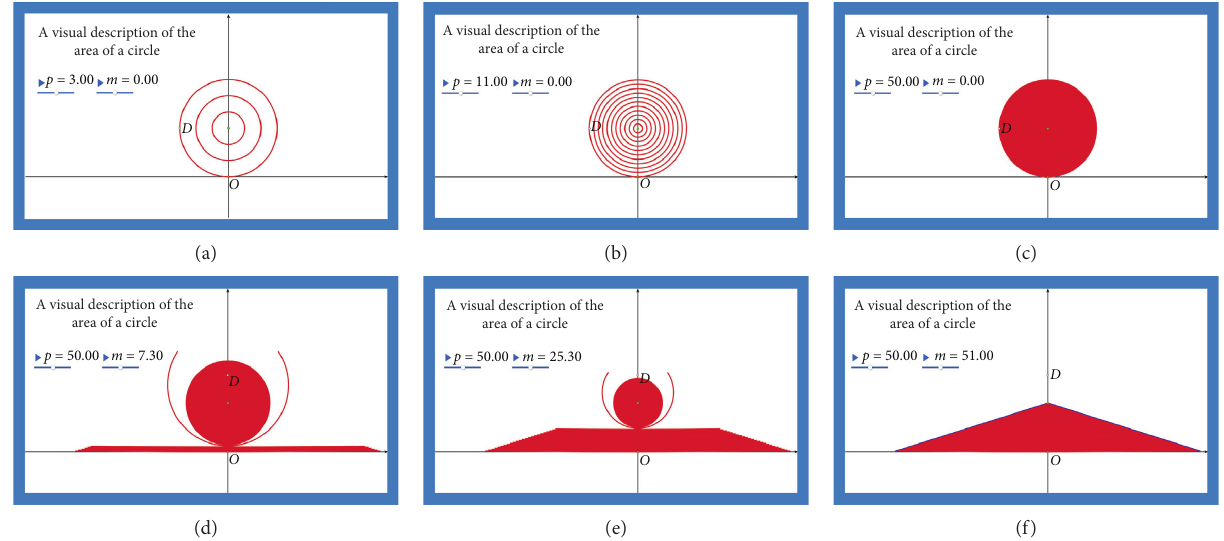
Figure 6: The picture preview of “circle area.” (a)–(c) Click the variable ruler p ; show the formation of the circle. (d)–(f) Click the variable ruler m ; show the decomposition of the rings.